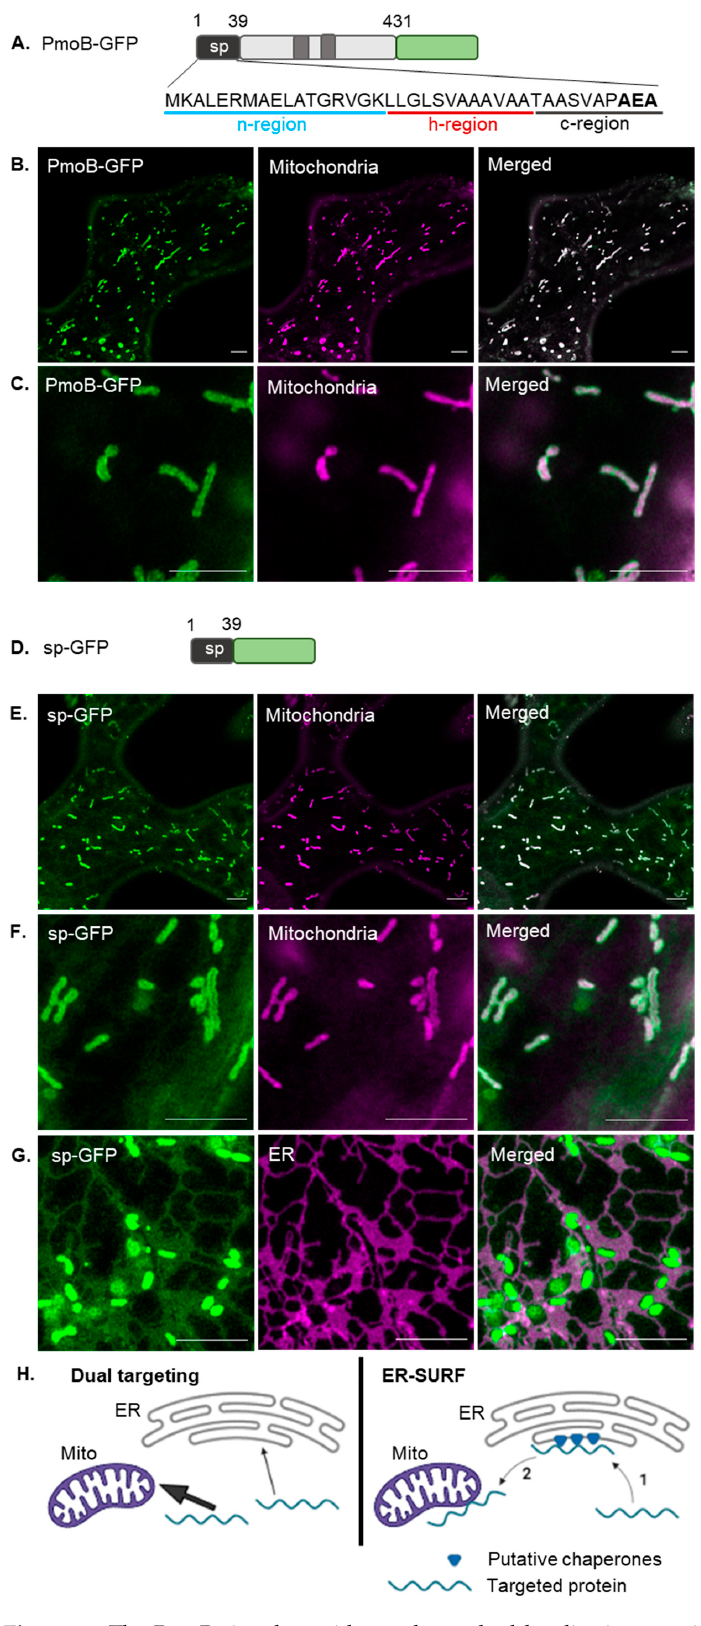
Figure 1. The PmoB signal peptide produces dual localisation to mitochondria and the ER in to- bacco cells. ( A ) Diagram of PmoB (in grey) with two transmembrane domains (darker grey squares), comprising a signal peptide between residues 1–39 (black rectangle). n-, h- and c-regions are